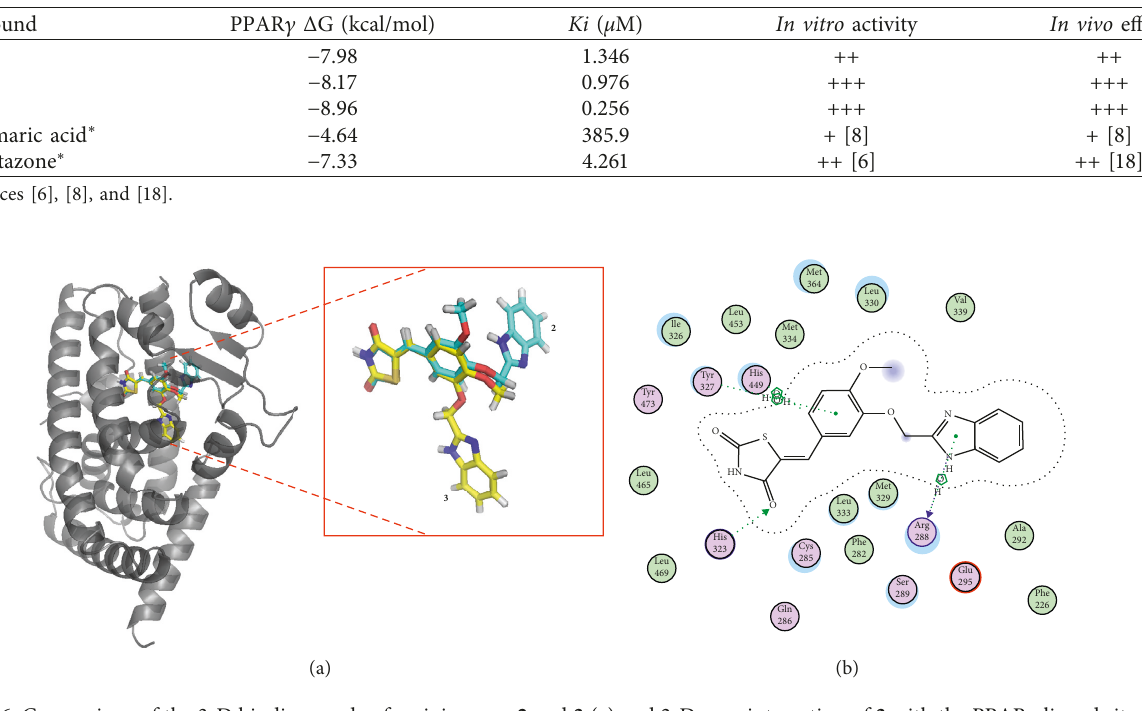
Figure 6: Comparison of the 3-D binding mode of regioisomers 2 and 3 (a) and 2-D map interaction of 3 with the PPAR c ligand site